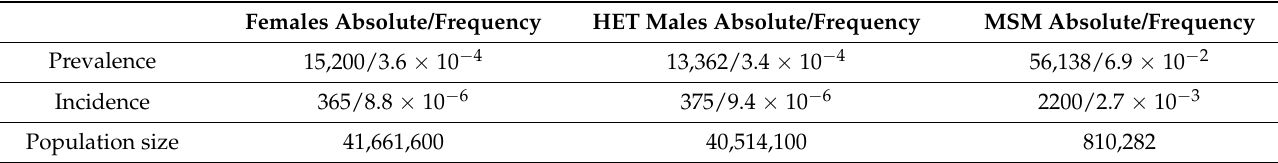
Table 2. Prevalence and incidence of HIV in Germany in 2015 as described by the Robert Koch Institute, i.e., the central institution of the German federal government with responsibility for disease monitoring and prevention. Females Absolute/Frequency HET Males Absolute/Frequency MSM Absolute/Frequency Prevalence 15,200/3.6 × 10 − 4 13,362/3.4 × 10 − 4 56,138/6.9 × 10 − 2 Incidence 365/8.8 × 10 − 6 375/9.4 × 10 − 6 2200/2.7 × 10 − 3 Population size 41,661,600 40,514,100 810,282 HET = heterosexual. MSM = men having sex with men.